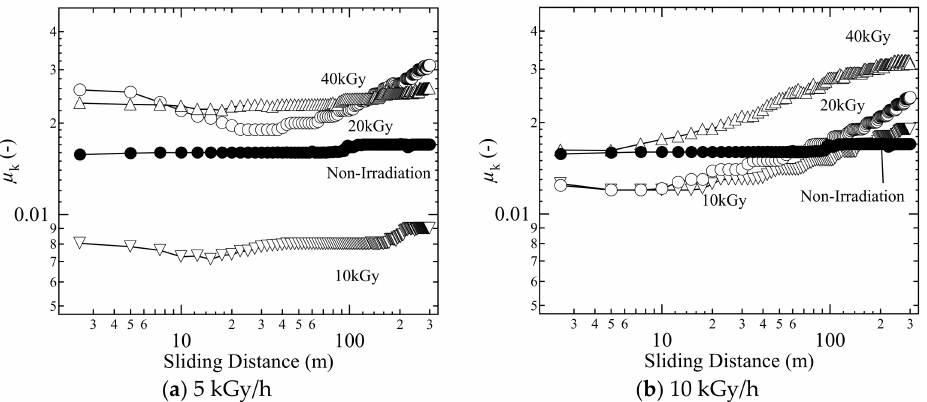
Figure 3. Coefficient of friction of gamma ray irradiated gels with ( a ) 5 kGy/h and ( b ) 10 kGy/h in reciprocating friction tests at body temperature (about 37 ◦ C); close circle, non-irradiation gel; inverted triangle, irradiance = 10 kGy; open circle, irradiance = 20 kGy; triangle, irradiance = 40